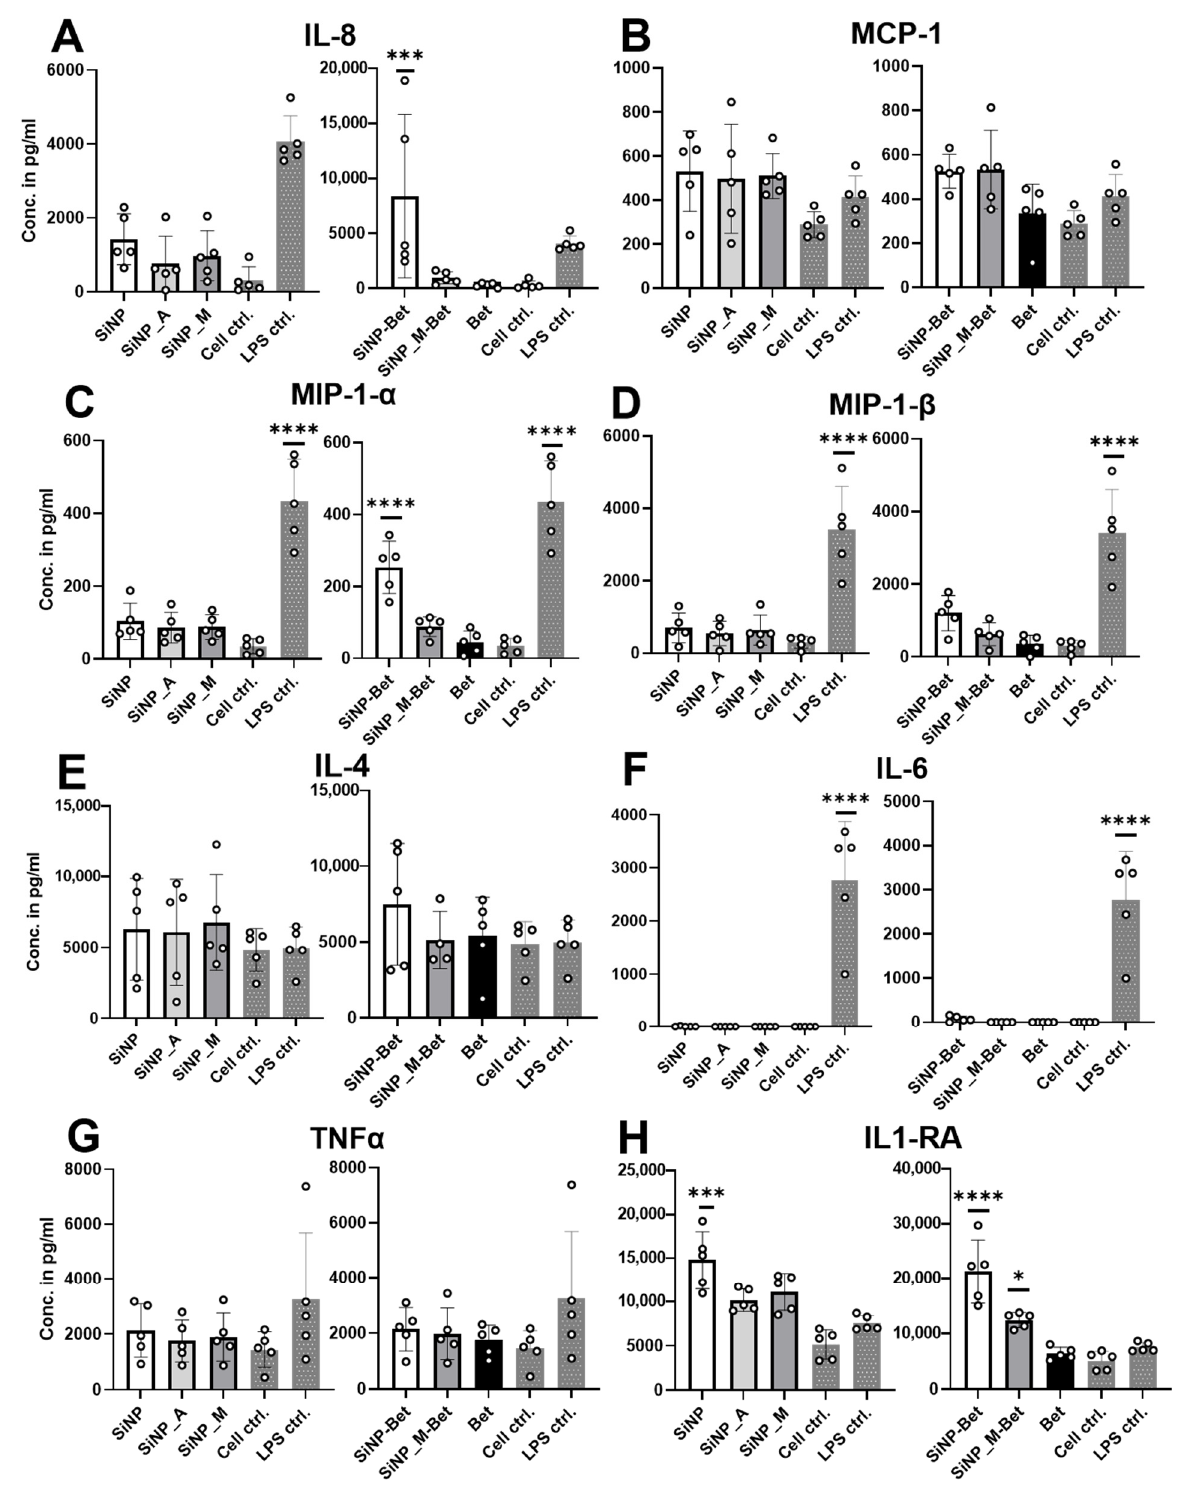
Figure 7. Cyto-/chemokine release of APCs. ( A ) IL8, ( B ) MCP-1, ( C ) MIP-1 α , ( D ) MIP-1 β , ( E ) IL-4, ( F ) IL-6, ( G ) TNF α , ( H ) IL1-RA. LPS was used as the positive control and a statistical significance was observed in comparison to the cell control, indicating successful stimulation. The particles were compared to Bet v 1 for statistical analysis ( n = 5 individual donors) (* p ≤ 0.05, *** p ≤ 0.001; **** p ≤